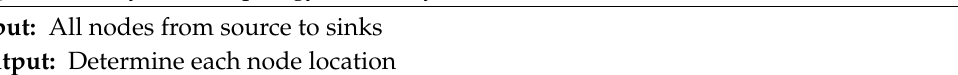
Algorithm 1 Dynamic Topology